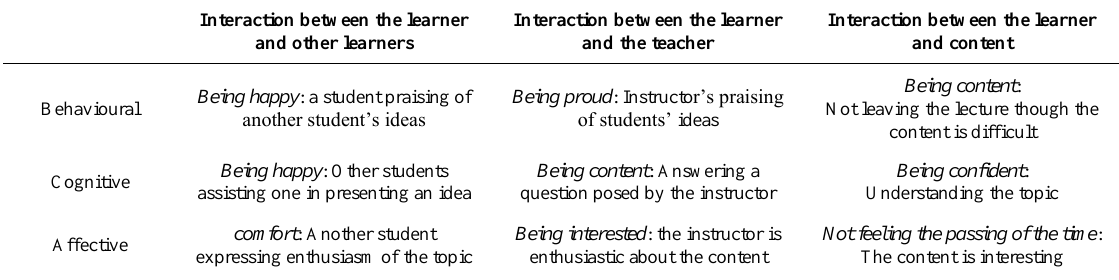
Table 3. Occurrences in the synchronous lectures that resulted in positive affective engagement